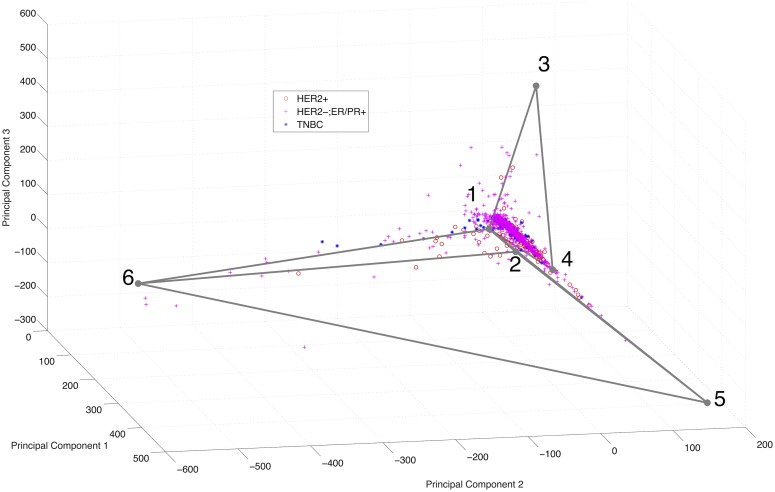
Visualization of TCGA combined RNA-Seq and CNV data with inferred maximum likelihood simplicial complex structure.The inferred structure of a tetrahedron and triangle sharing a point corresponds to two phylogenetic branches, one with four components and one with three components. Data points, corresponding to distinct tumor samples plotted in principal component space, are color coded by immunohistological subtype (red circle: Her2+, purple plus: ER/PR+, blue asterisk: triple-negative).